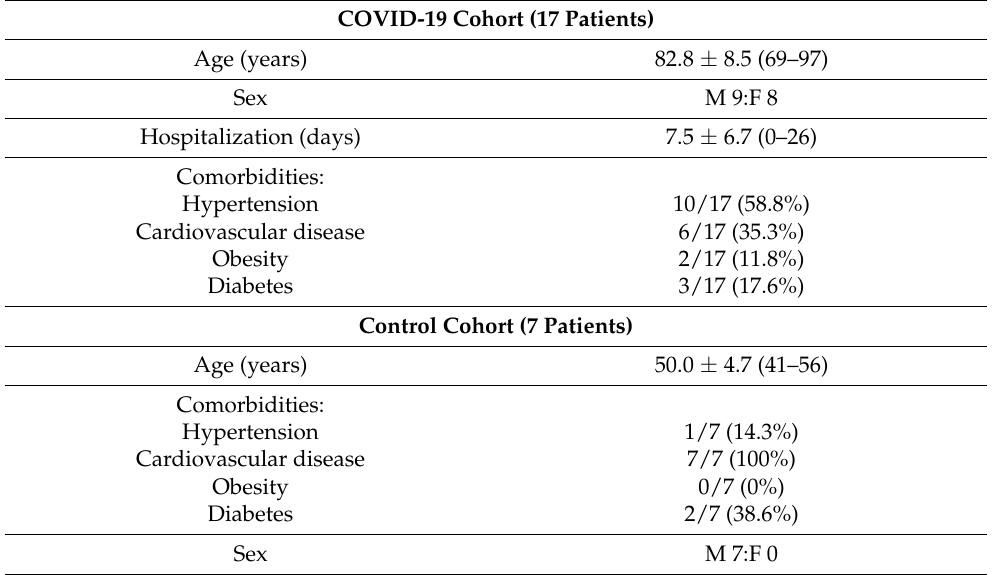
Table 1. Clinico-pathological features of the considered